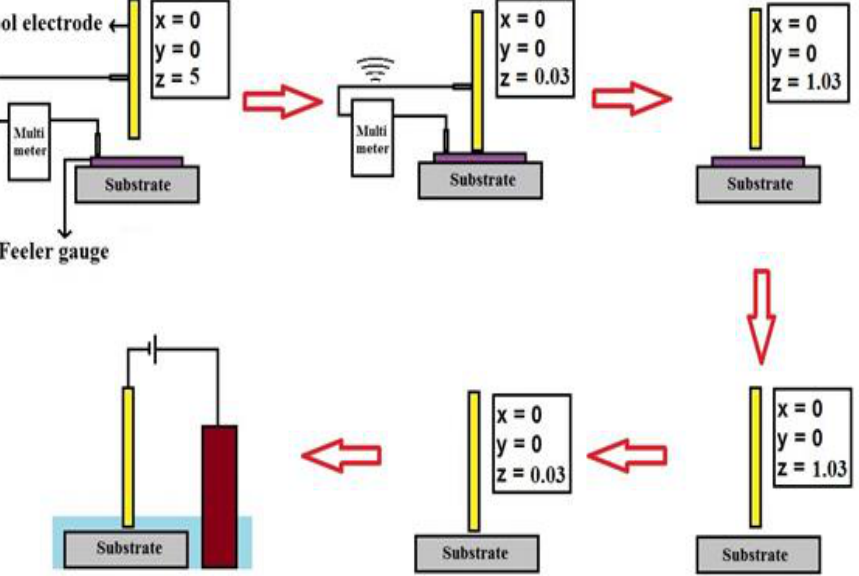
Figure 2. Setting the working gap between the tooltip and the substrate surface using the feeler